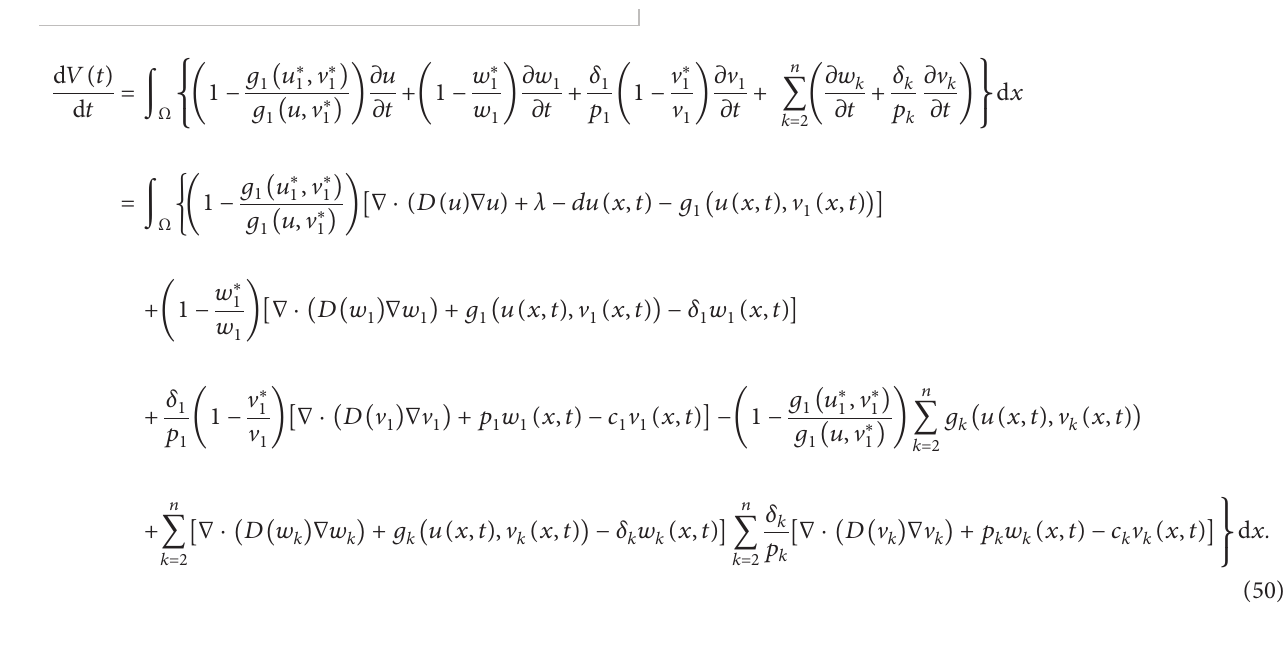
Figure 1: Choosing m and the infection-free equilibrium E